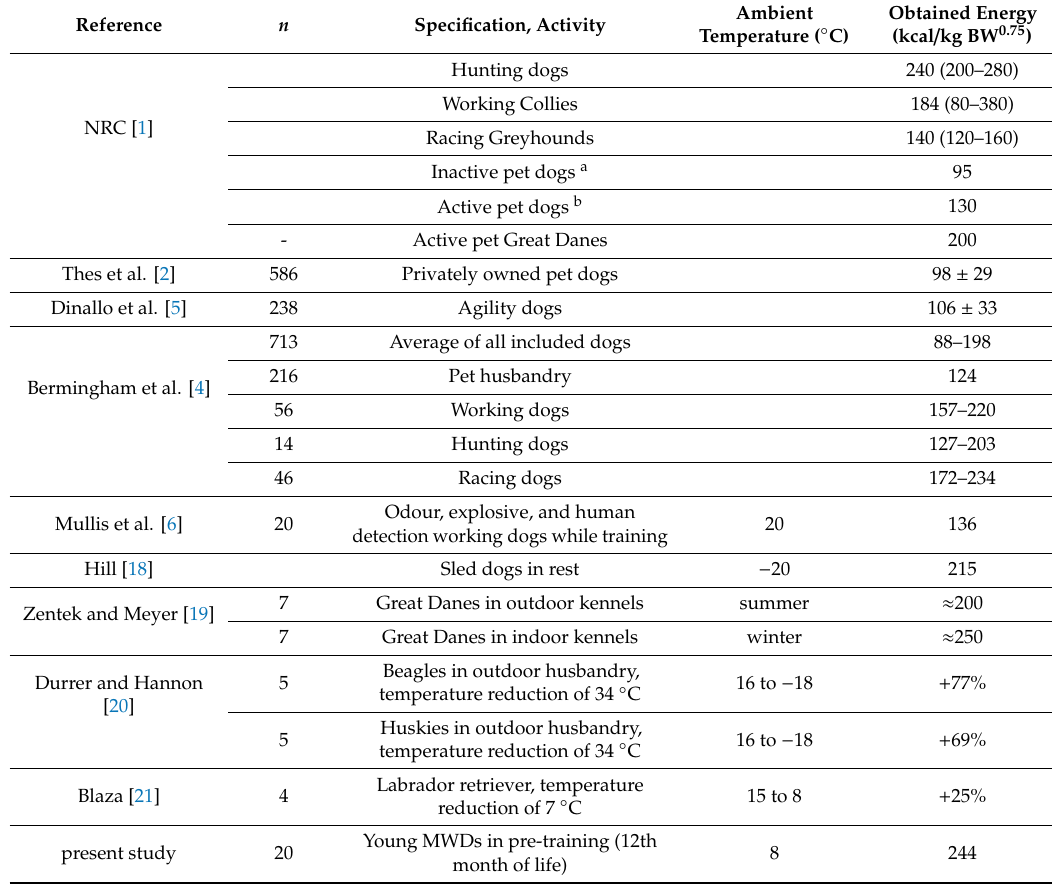
Table 5. Energy requirements and supply of dogs in relation to activity and ambient